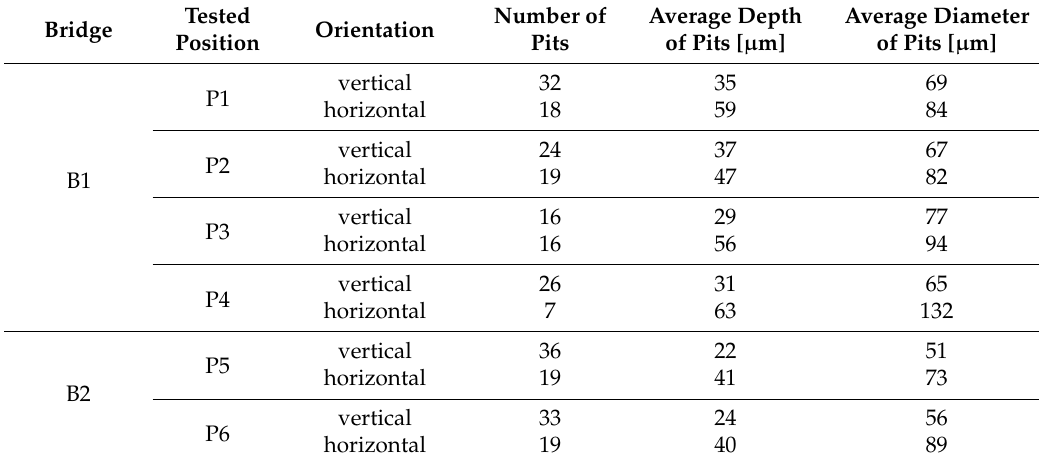
Table 1. Pitting in steel surface after removal of corrosion